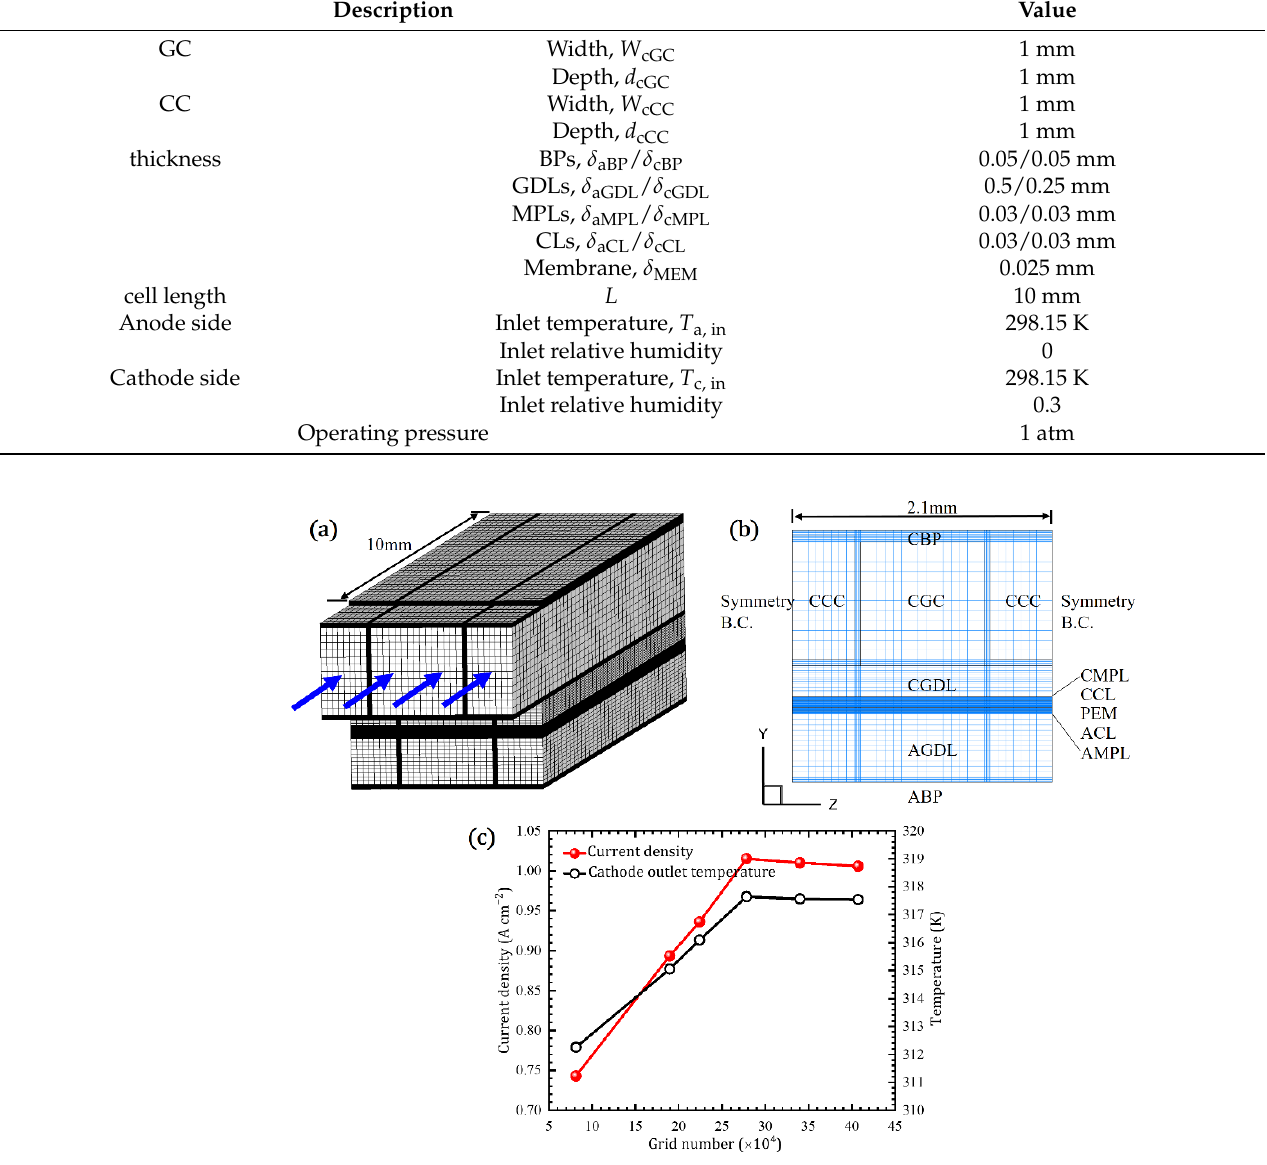
Figure 3. Computational domain and grid independence test: ( a ) grid configuration, ( b ) front view of domain and ( c ) grid independent test. Table 5. Structural and operating parameters.